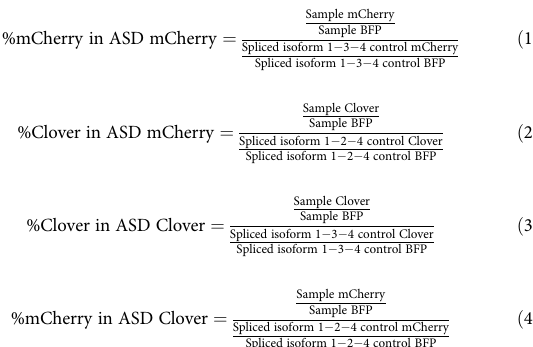
Fig. 15. The binding site sequences for TALE-TF 1 and TALE-TF 2 were cloned into the reporter plasmids with mCherry or BFP between the XbaI and BamHI restriction sites. Primers listed in Supplementary Table 2 were annealed with overhangs corresponding to the two restriction sites and introduced into the reporter plasmid using Gibson assembly. All reporter plasmids are listed in Supplementary Table